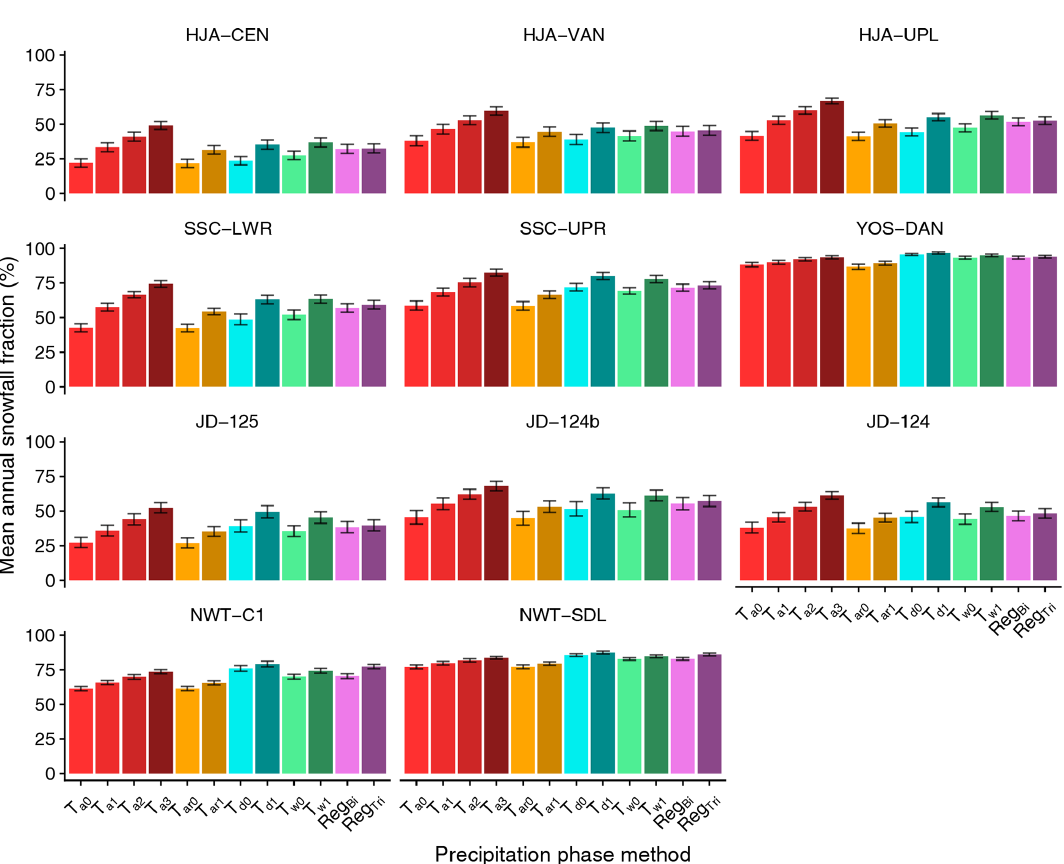
Figure 5. Mean annual snowfall fraction at the 11 study stations for the different precipitation phase methods. The whiskers represent the standard error of annual snowfall fraction for the 8 simulation years. For this plot and all subsequent figures showing the station data, the maritime sites are shown in the top two rows, the intermountain site is in the third row, and the continental site is in the bottom